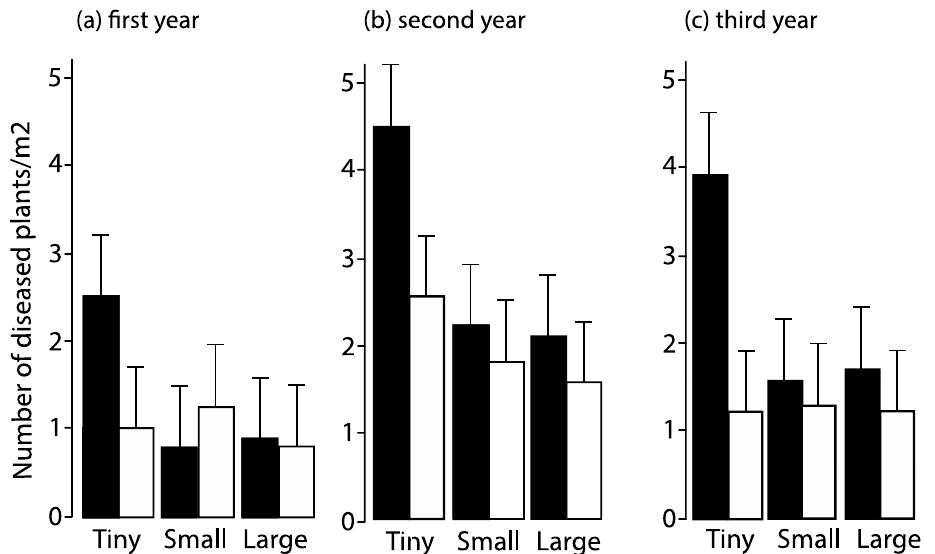
Figure 6. Number of Bromus erectus tillers (per m 2 ) infested with Epichloë bromicola in tiny, small, and large fragments (black bars) and in the corresponding control plots (open bars) in the first year ( a ), second year ( b ), and third year ( c ) of the experiment. Means ± SE are shown. Redrawn from Groppe et al. [30].